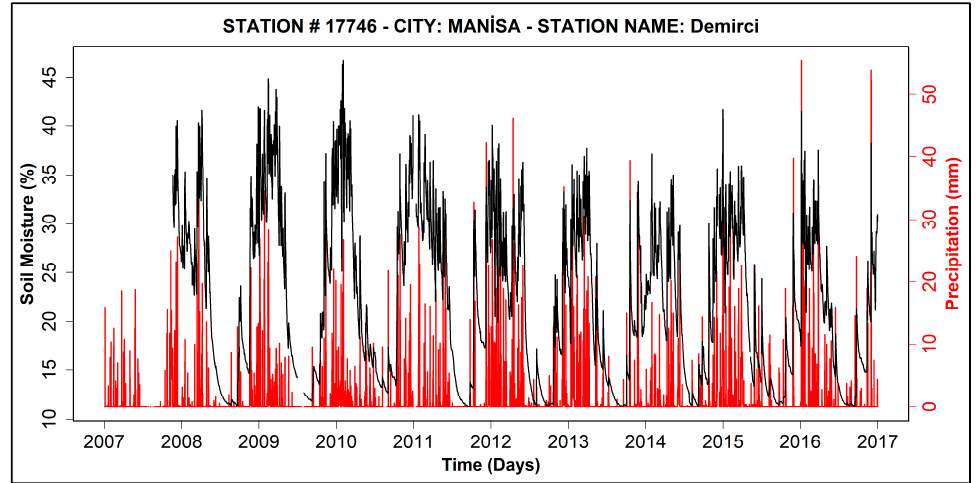
Figure 4. Daily soil moisture and precipitation time series over station 17746